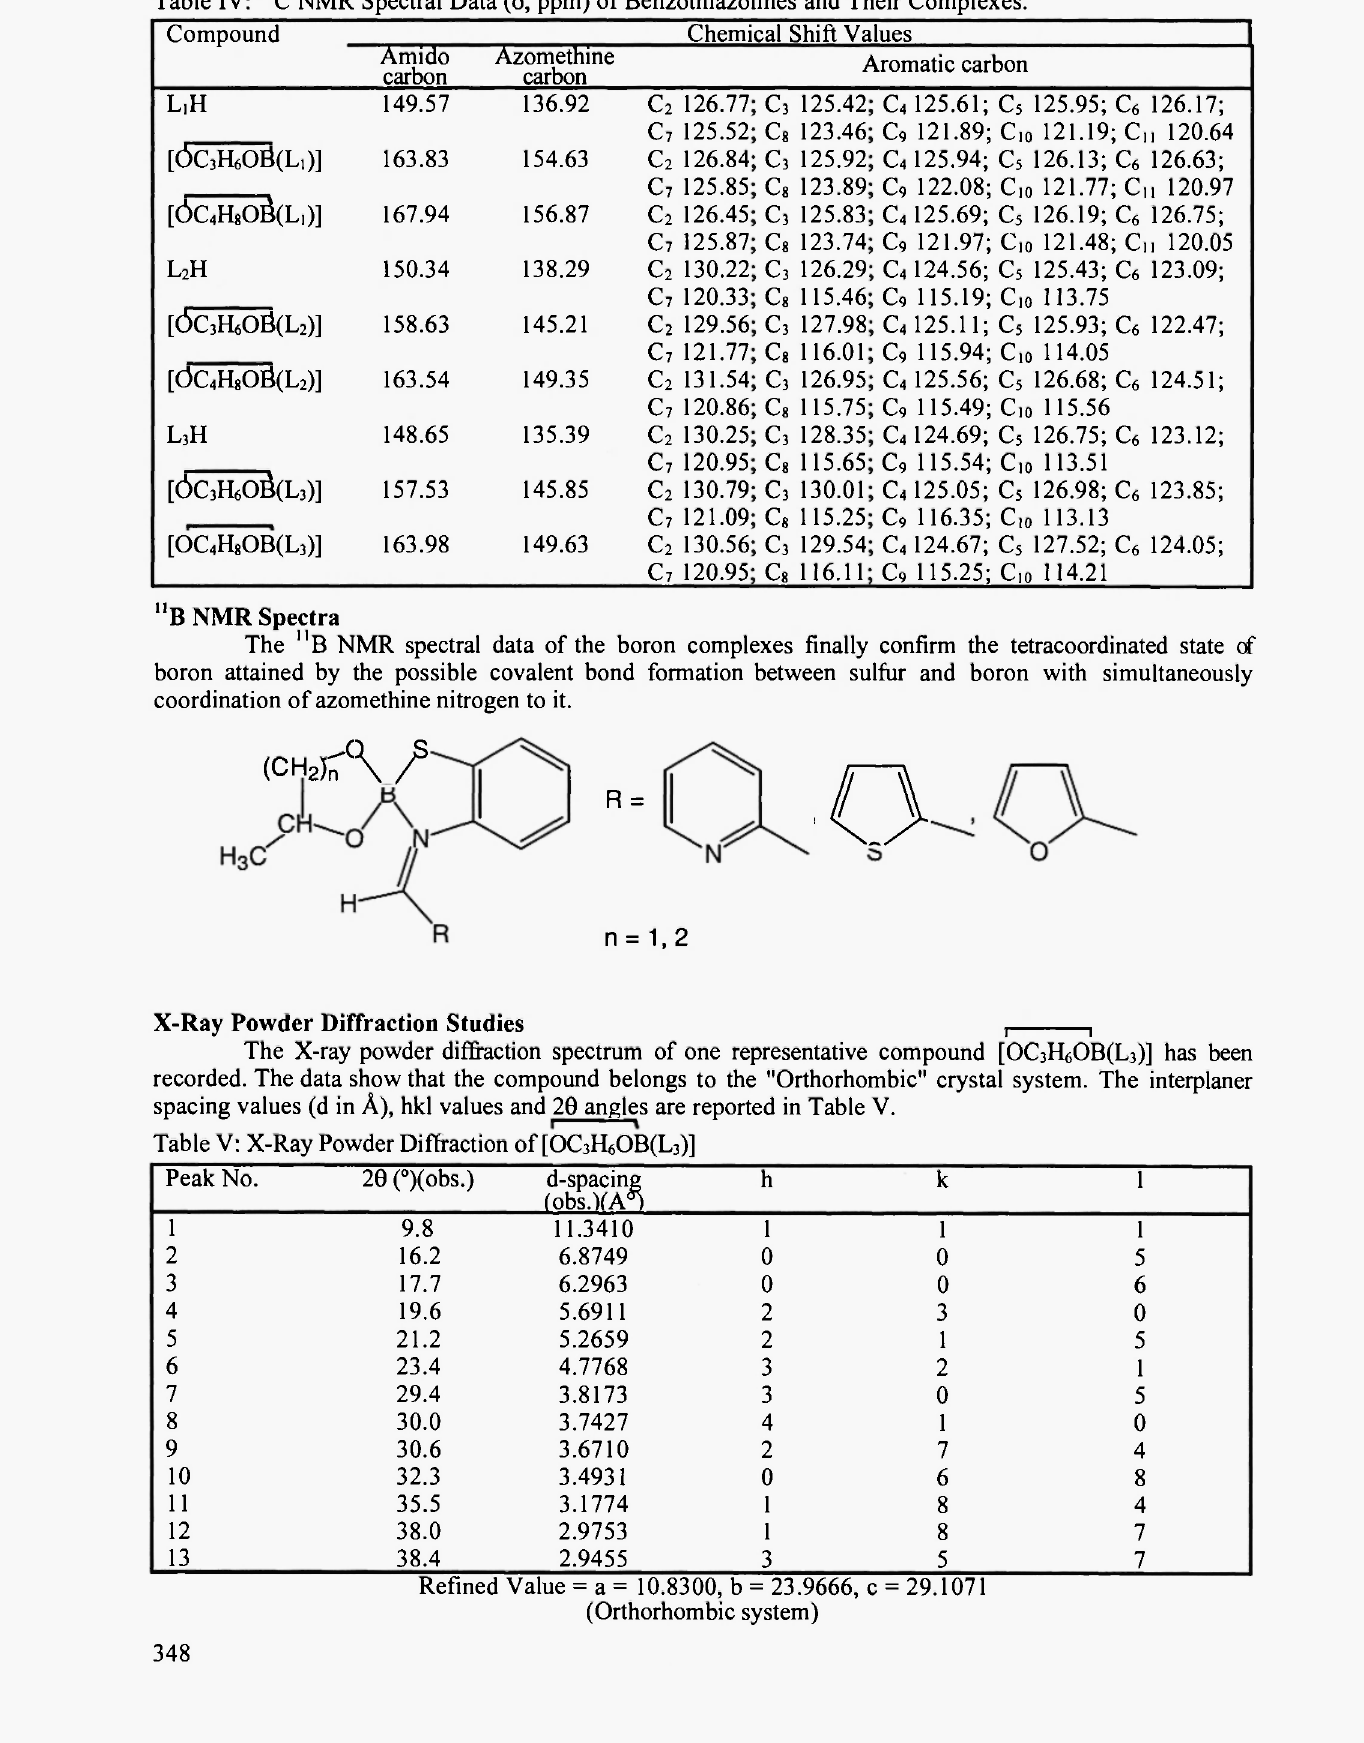
Table IV: n C NMR Spectral Data (δ, ppm) of Benzothiazolines and Their Complexes. Compound